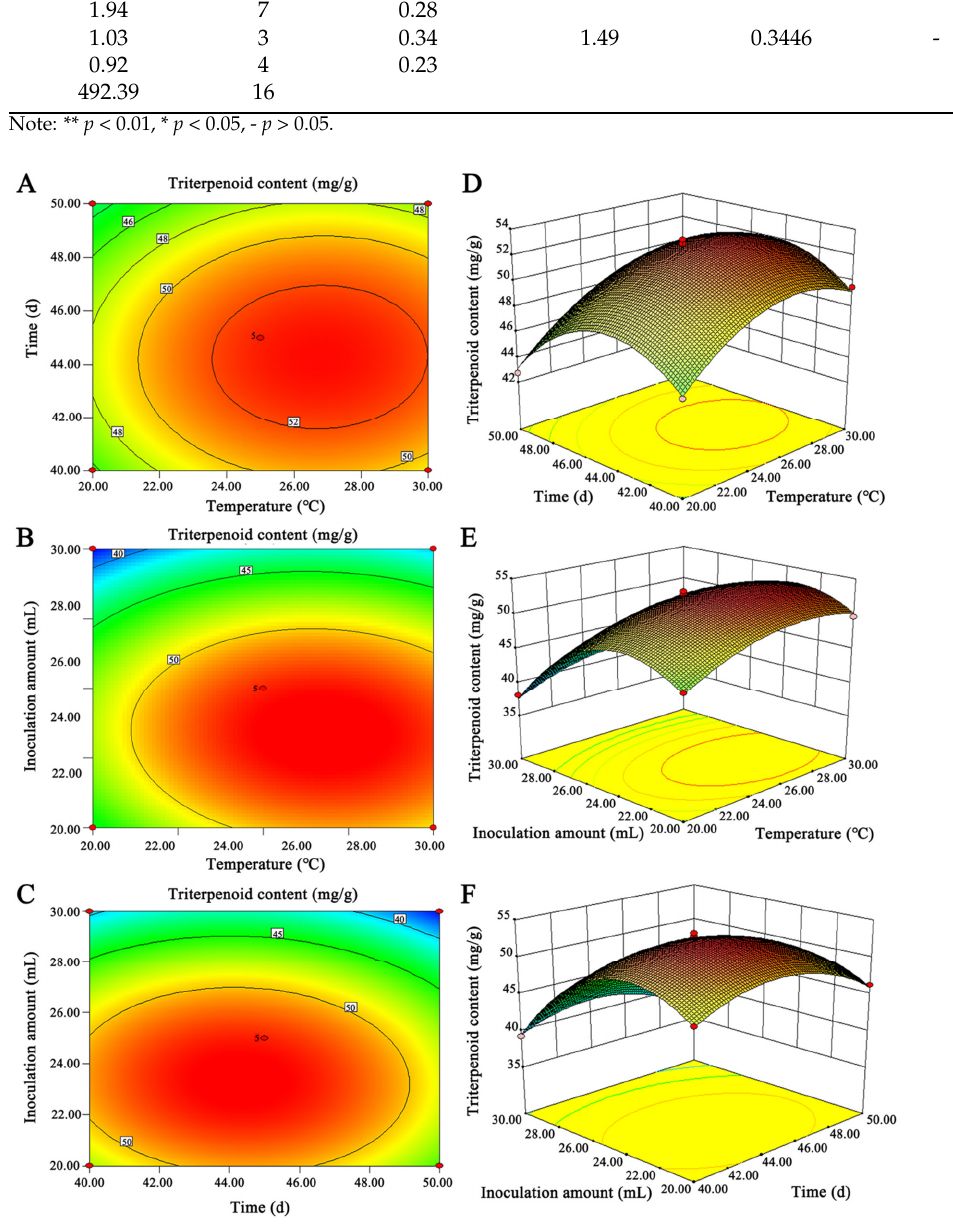
Figure 1. Response surface and contour map of the influence of the interaction of various factors on the content of triterpenoids. ( A – C ) Two-factor interactive contour maps and ( D – F ) two-factor interactive 3D maps.